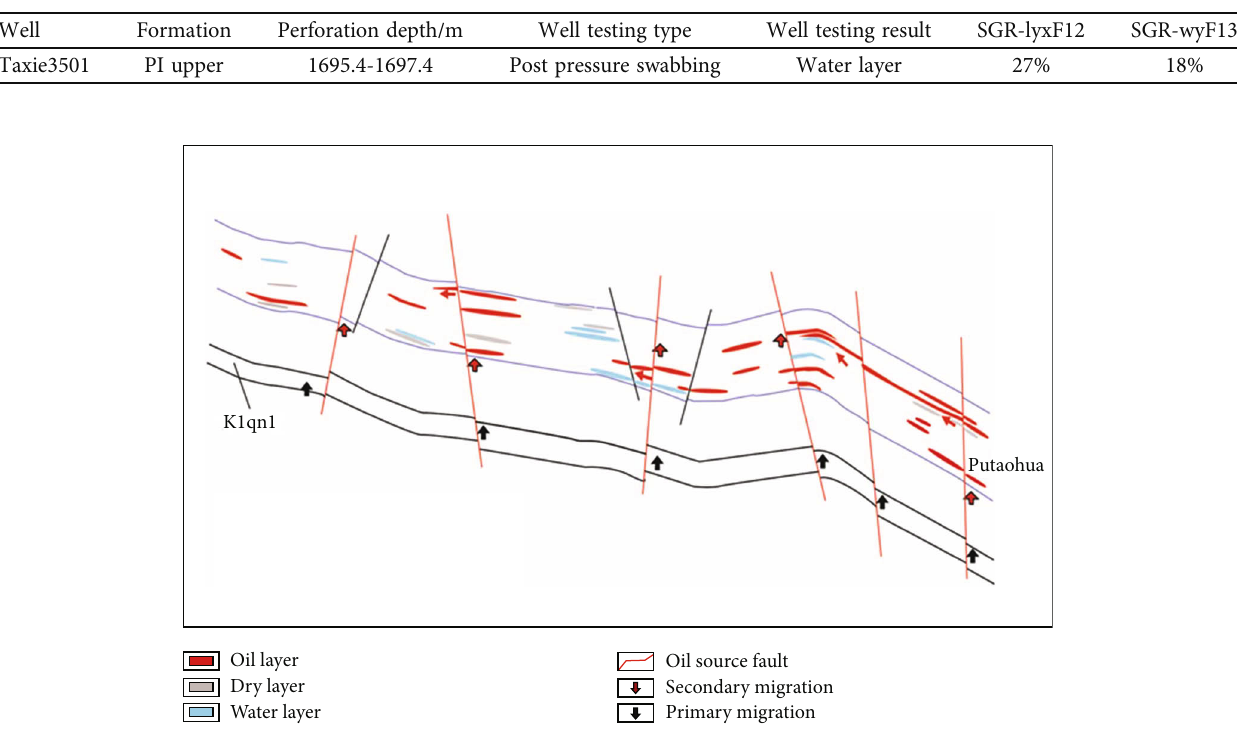
Figure 8: Reservoir forming mode diagram of Putaohua oil layer.